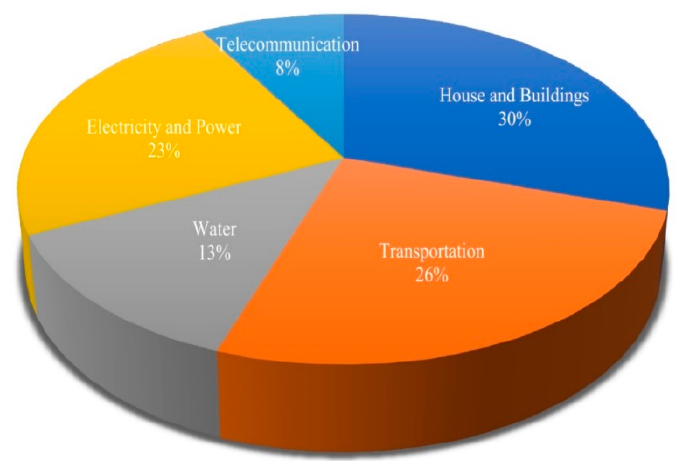
Figure 3. The summary of studies evaluated based on the infrastructure types.